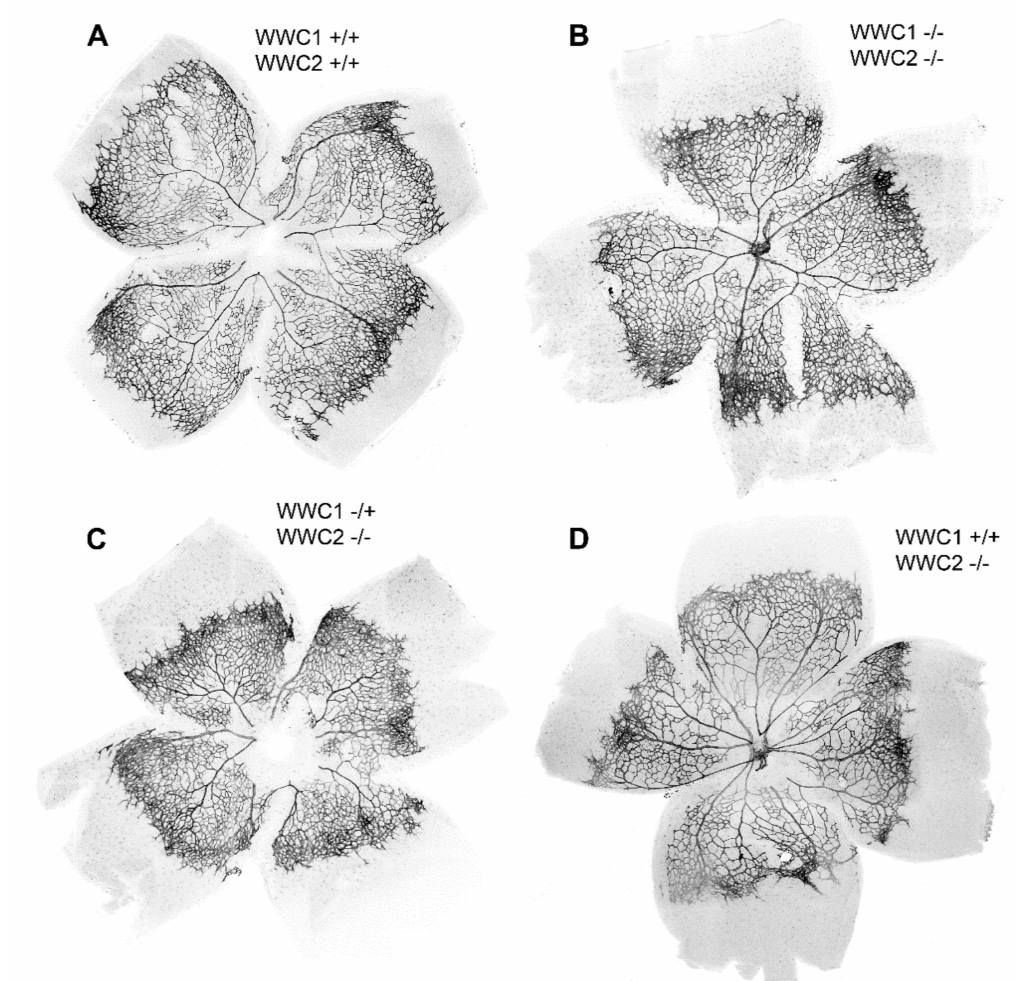
Figure 1. Retinal whole mounts from P6 mice with blood vessels labelled with isolectin B4. The control is shown in ( A ), and the three knock-out groups in ( B – D ). The latter did not express WWC2 and differed in their WWC1 expression as indicated. They exhibited a dense vascular network in the peripheral plexus, the so-called, “hypersprouting areas”, and a smaller portion of the retinal